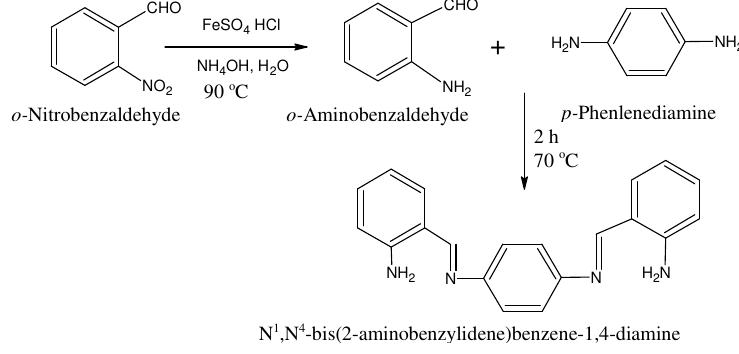
Figure 1. Synthesis of the ligand